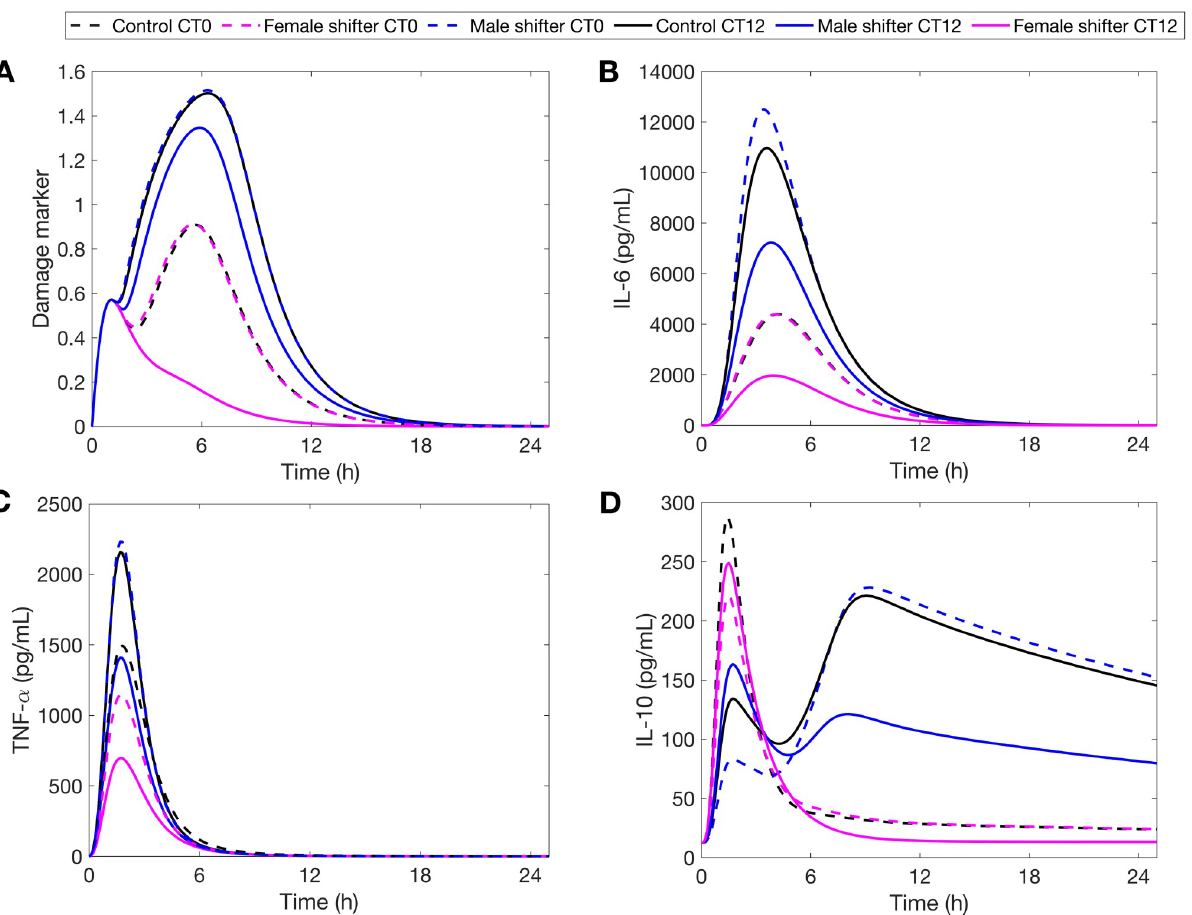
Fig 8. Sex-specific response to infection during CJL at CT0 and CT12. Model simulations of the time course of IL-6 , TNF- α , IL-10 and the damage marker for controls (black) against CJL males (blue) and CJL females (pink) in response to endotoxin challenge of 3mg/kg administered at CT0 and